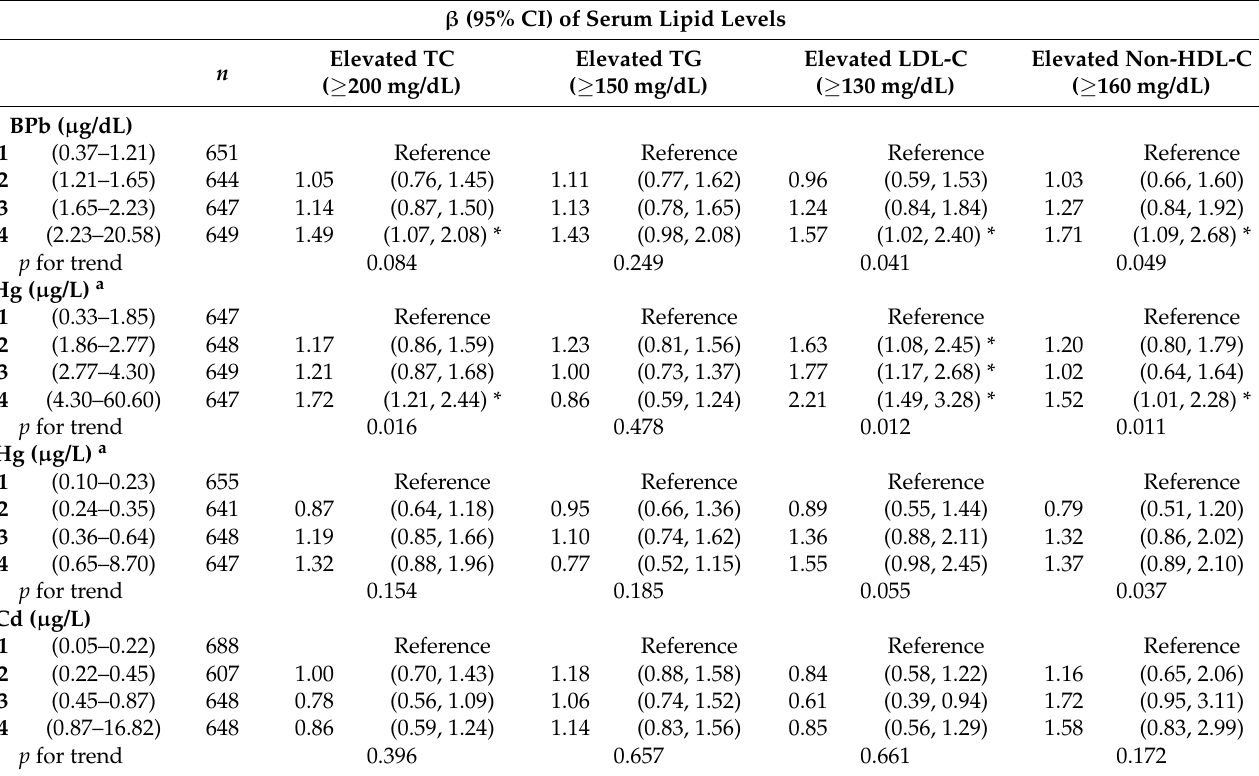
Table 3. Multivariate logistic regression of serum lipid profiles by heavy metal concentrations in participants ( n =